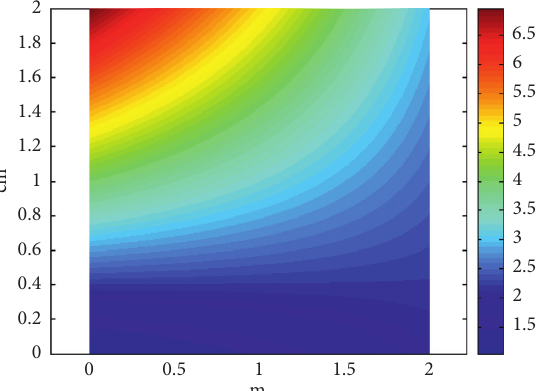
Figure 4: Treatment map of distance between surface working face and cut hole in subsidence area ( d � 50 cm).